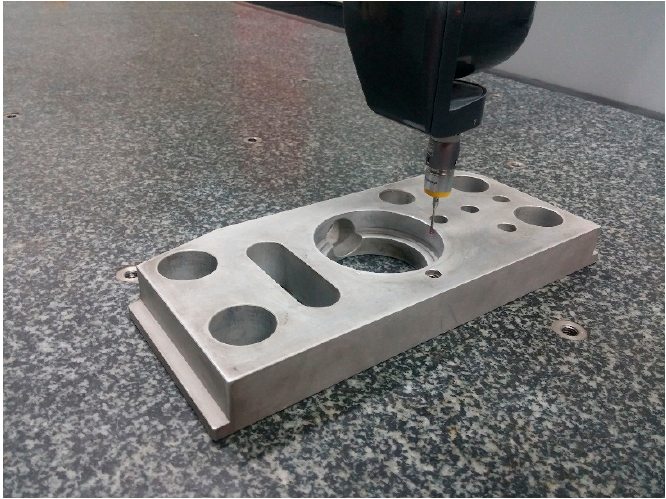
Figure 6. The measured circle.